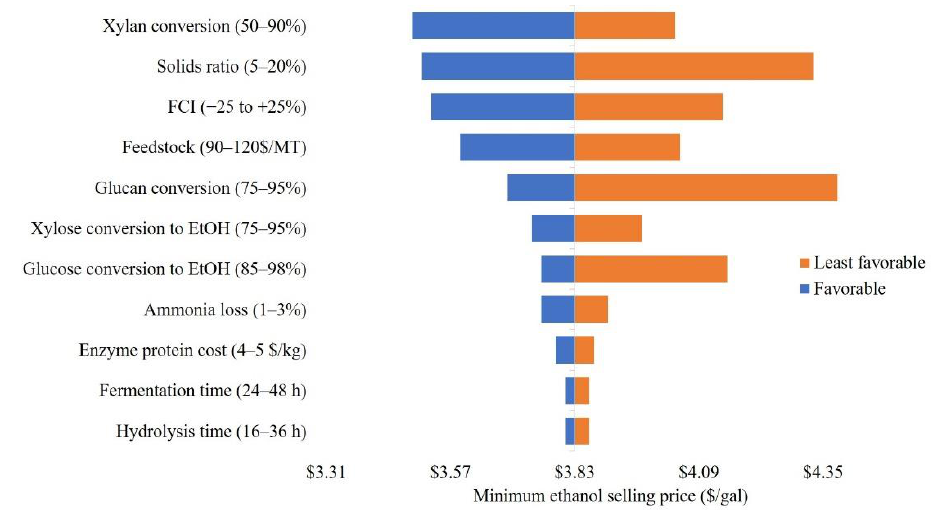
Figure 4. Sensitivity analysis for PT3 (55 °C 19 h, 16% ammonia) at low enzyme loadings for pelleted biomass.